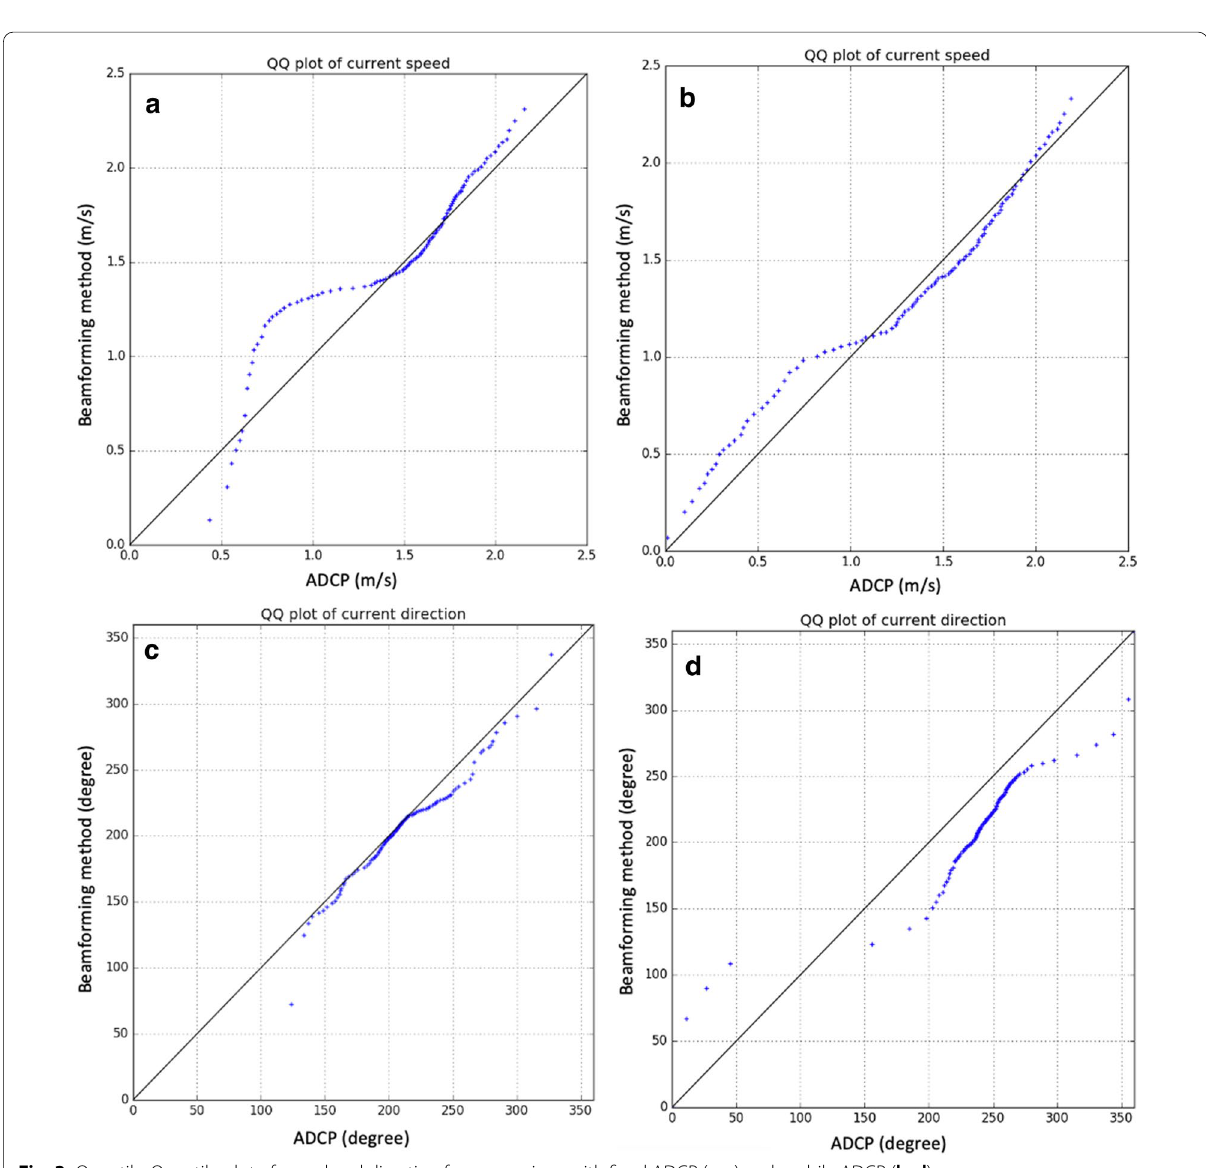
Fig. 3 Quantile-Quantile plot of speed and direction for comparison with fixed ADCP ( a , c ) and mobile ADCP ( b , d